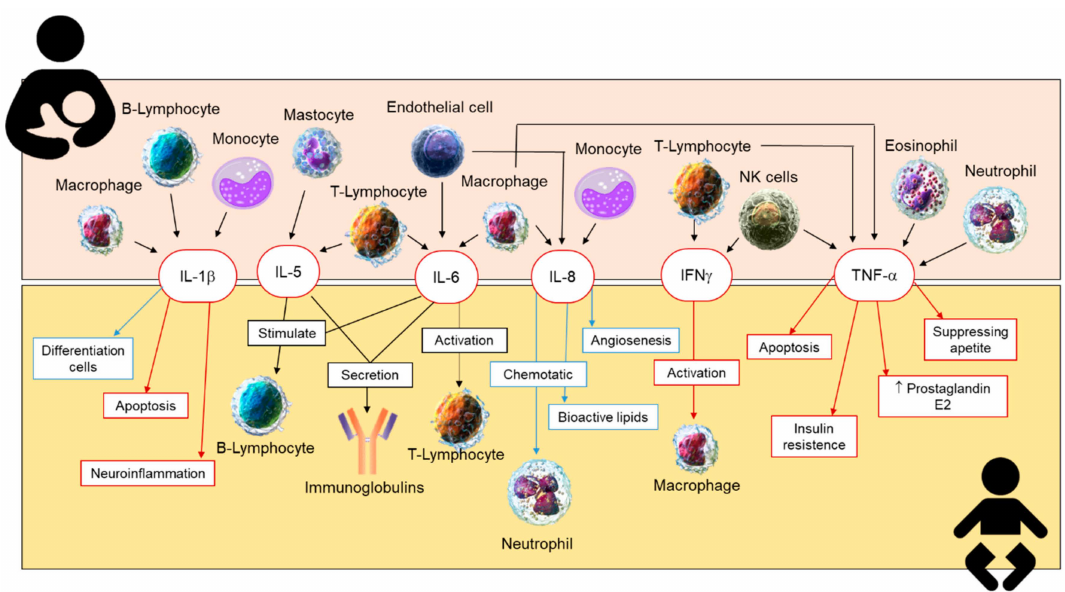
Figure 3. Synthesis of the inflammatory cytokines present in human breastmilk and their e ff ect on the neonate. IL-1 β , interleukin-1 β ; IL-5, interleukin-5; IL-6, interleukin-6; IL-8, interleukin-8; IFN γ , interferon gamma; TNF- α , tumor necrosis factor